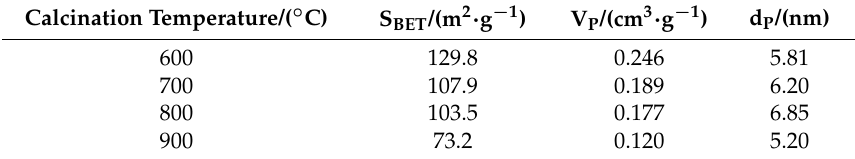
Table 3. Surface area and pore size and volume of the Cr-Pt/WZ catalysts calcined at 600–800 ◦ C. Calcination Temperature/( ◦